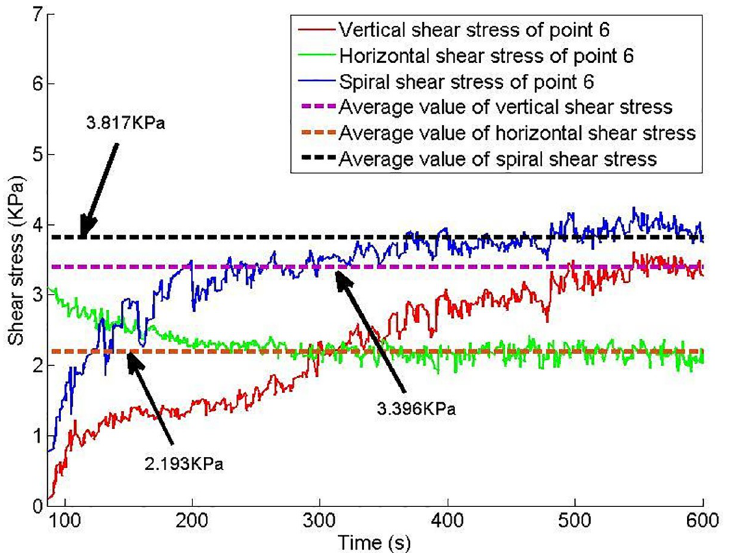
Fig 18. Shear stress of testing point 6.